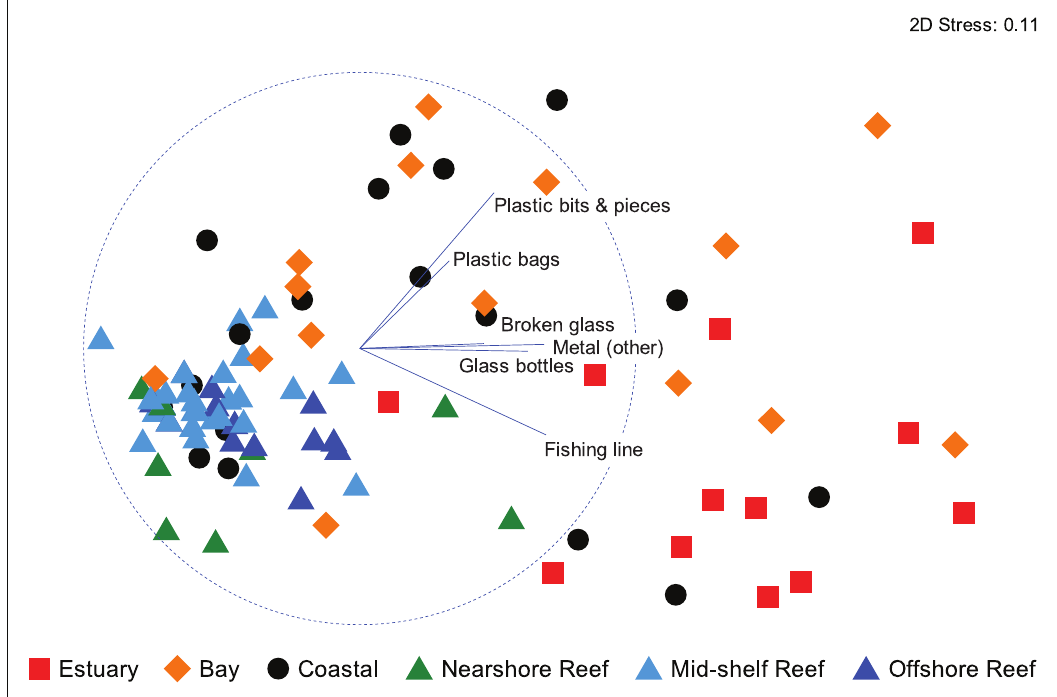
Figure 3. Non-metric multidimensional scaling ordination of debris items recorded from 120 sites. Data points represent averages of transects deployed at each site. Vectors are displayed for debris items that were consistently ranked highly in SIMPER analyses of differences among habitats. The vector line indicates the plane of increasing abundance, and the length relative to the circle indicates the strength of the correlation (Spearman).